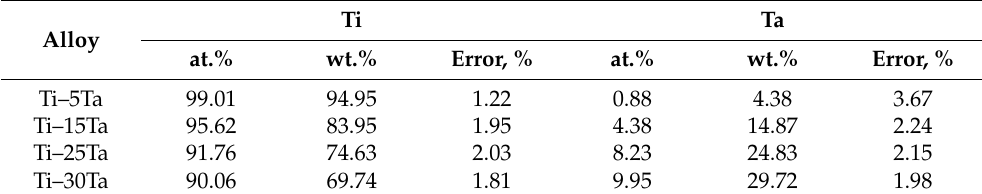
Table 3. EDS global analysis on micro-areas for Ti–xTa alloys.